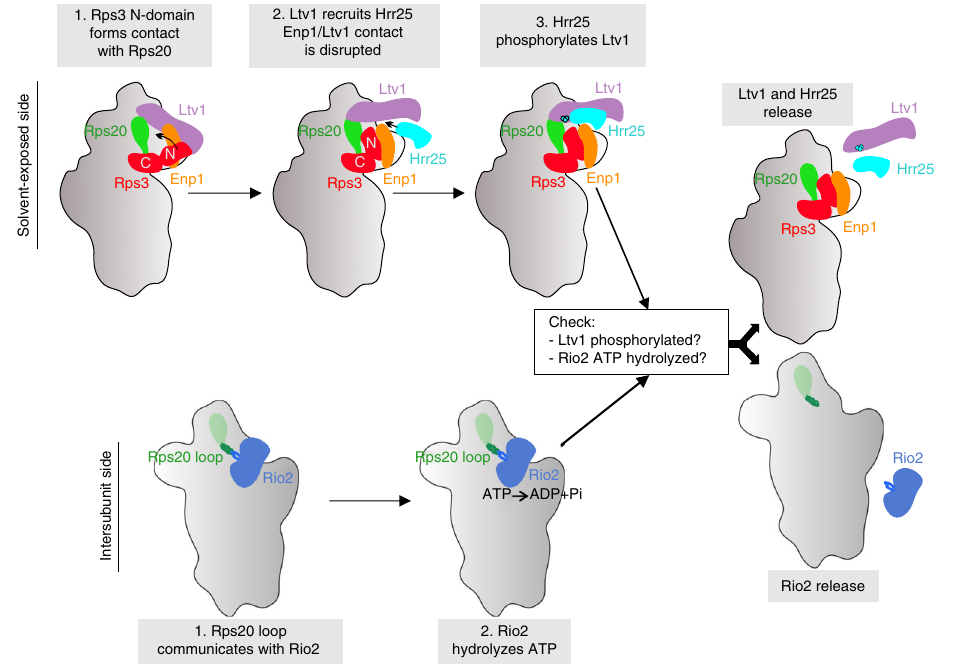
Fig. 7 Model of Rps20-mediated coordination of cytoplasmic pre-40S maturation events. Maturation events on the solvent-exposed and intersubunit side of pre-40S subunits converge into a fi nal maturation event leading to the release of Ltv1 and Rio2 (see “ Discussion ”